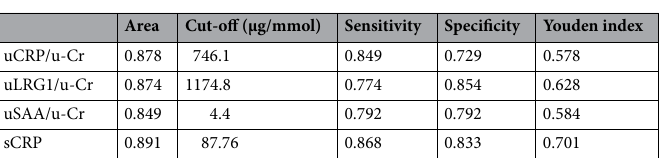
Table 6. The diagnostic value of identified biomarkers.